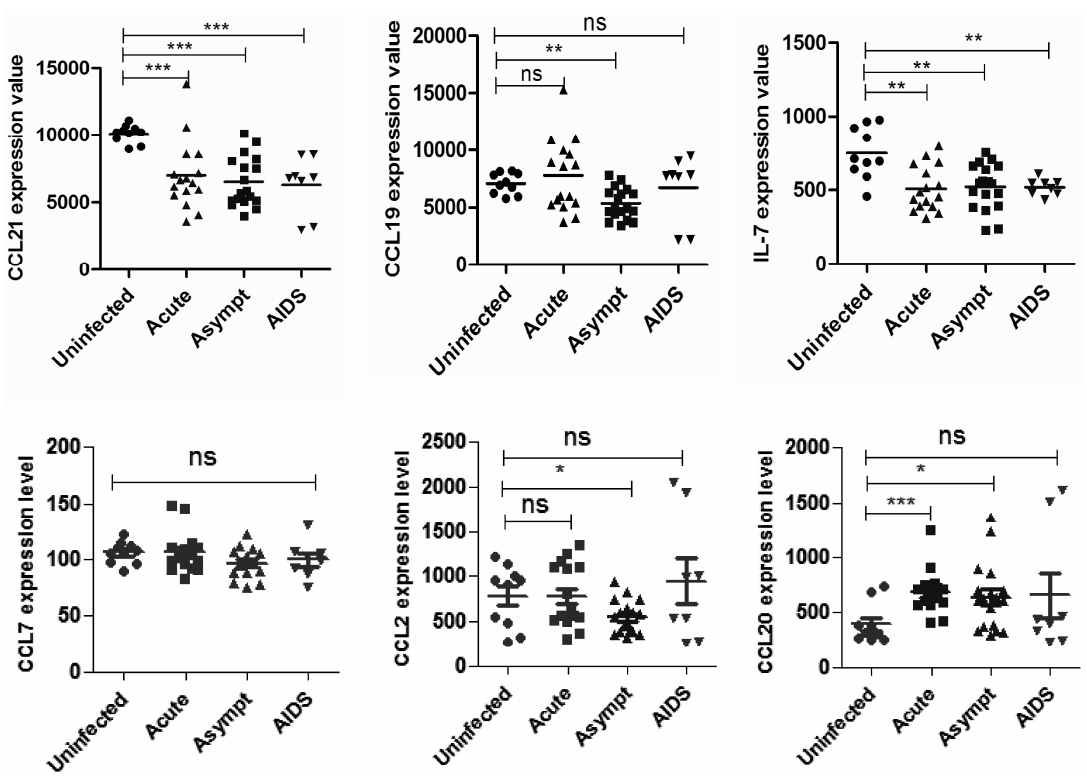
Figure 1. Lymphoid cytokine downregulation in human immunodeficiency virus (HIV)-infected patients. Microarray analysis of HIV-infected patients: mRNA expression of cytokines in lymph nodes at different stages (uninfected, acute, asymptomatic, or AIDS stage).* p < 0.05; ** p < 0.01; *** p < 0.001; ns indicates not significant.